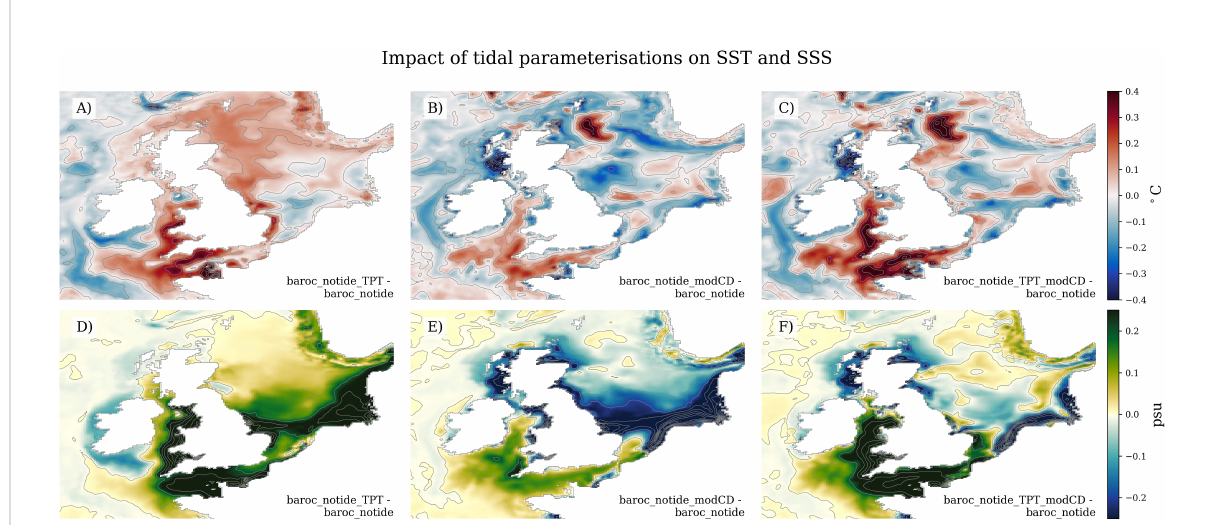
FIGURE 9 Impact of tidal parameterisation on the mean SST (A – C) and SSS (D – F) . How the mean SST and SSS changes (relative to the baroc_notide) when applying: (A, D) the TPT parameterisation, (B, E) the modi fi ed bed drag coef fi cient, and (C, F) ,